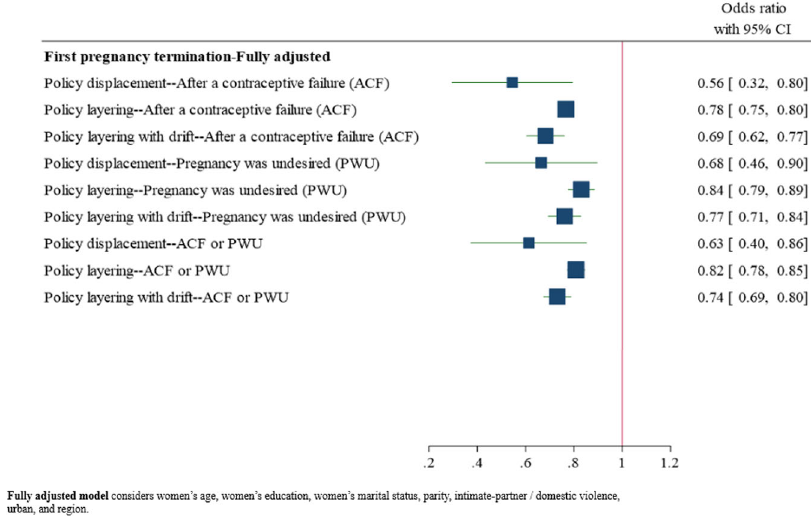
Fig. 4 Odds ratio of induced pregnancy terminations (after a contraceptive failure (APC), pregnancy was undesired (PWU) and ACF or PWU) fully adjusted (Colombia 2000 – 2016; N =